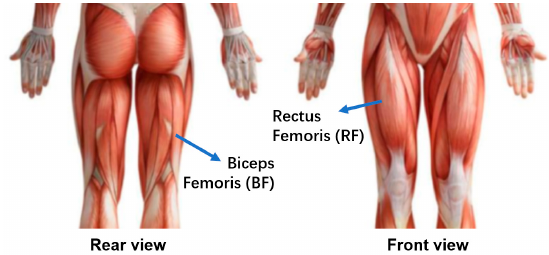
Figure 6. Rear and front view of the human thigh illustrating the selected two muscles. In our application here, the electrodes were placed only on the RF.